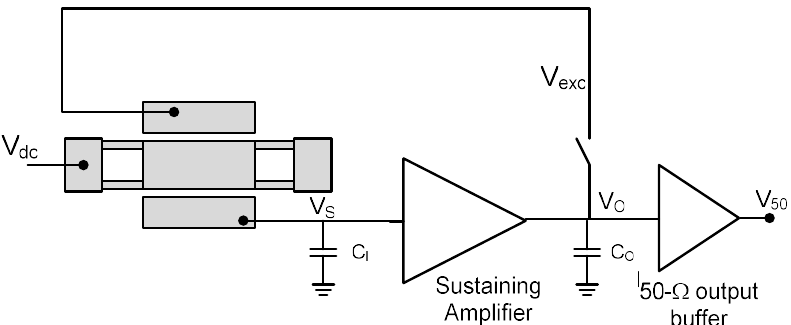
Figure 2. Conceptual circuit schematic of the lateral moving plate resonator into a Pierce oscillator topology.